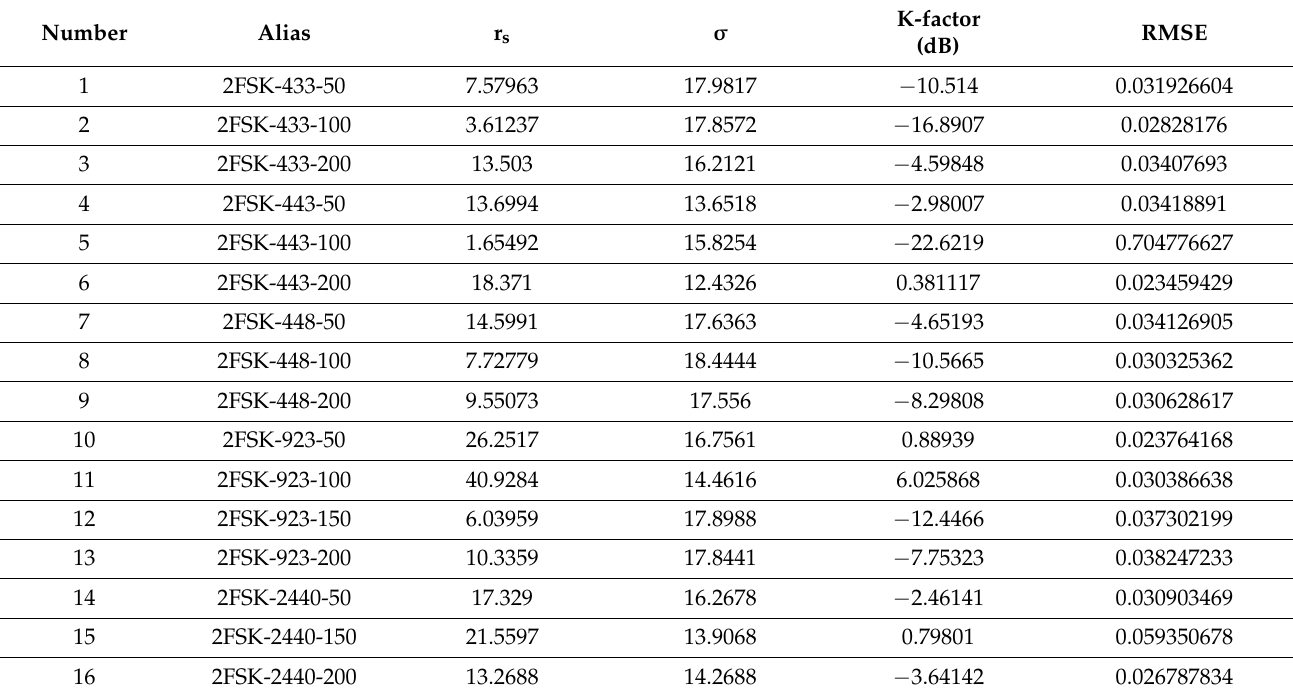
Table 4. Conventional fitted Rician parameter.